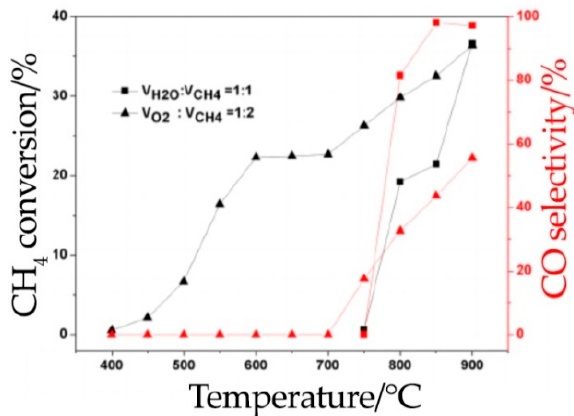
Figure 12. Catalytic activity of Sr 2 FeMoO 6– δ . Reproduced with permission [47]. Copyright 2018, John Wiley & Sons.